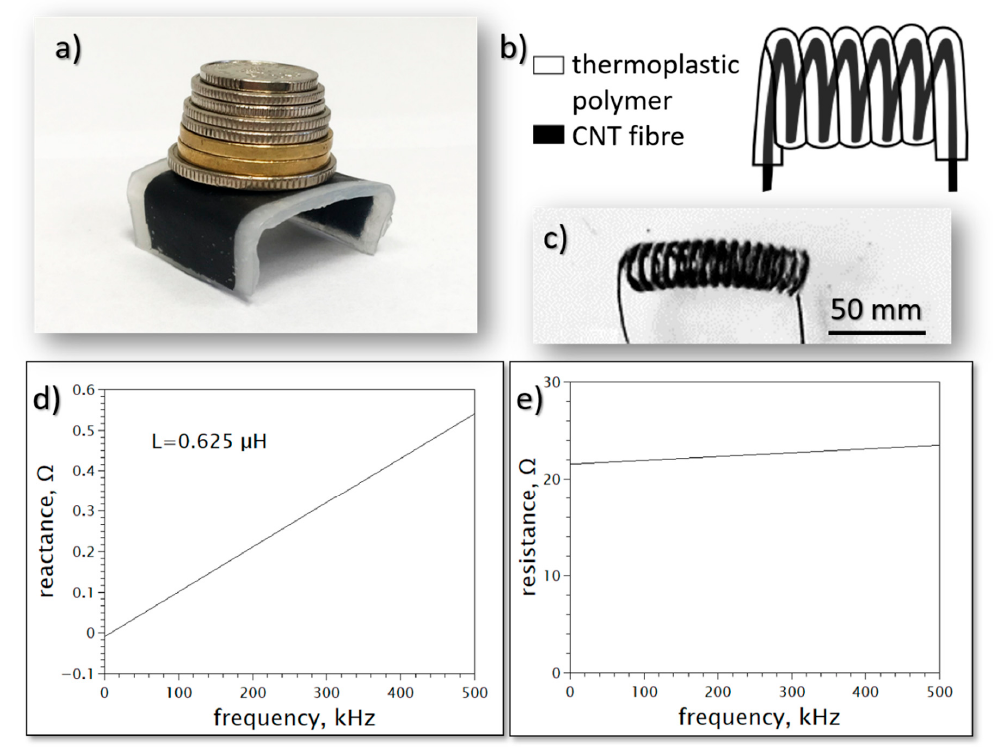
Figure 5. ( a ) Thermoformed low-density polyethene sheets with embedded conductive CNT film. ( b ) Design of a self-standing coil made from CNT fiber coated with a thermoplastic polymer and ( c ) its practical realization with the use of Nylon 6 polymer. ( d ) Imaginary and ( e ) real part of the impedance of the 10 turns CNT coil vs. frequency.